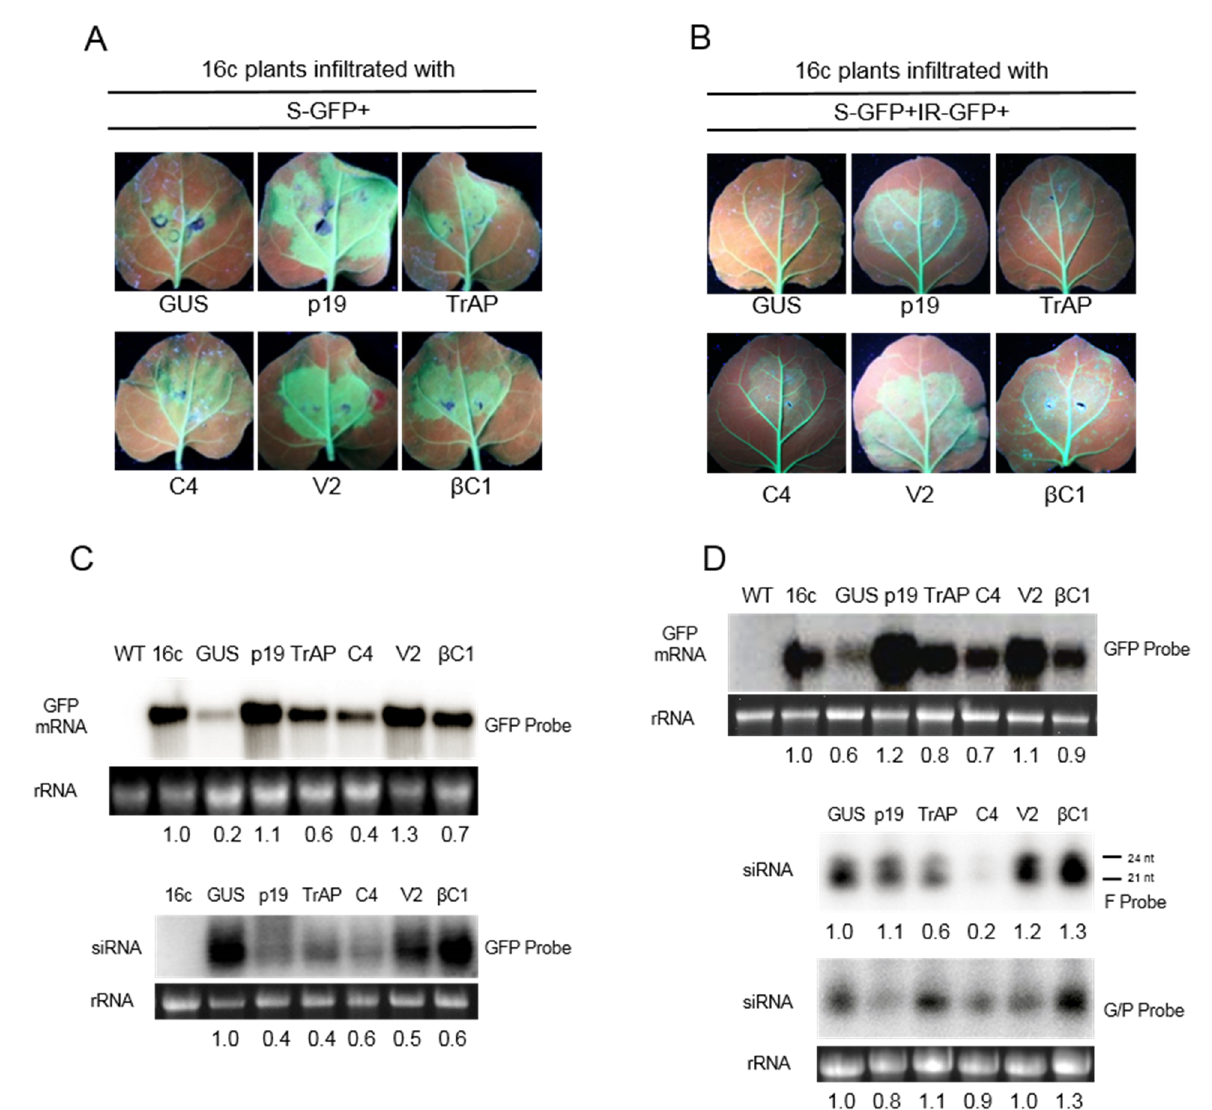
Figure 1. Suppression of gene silencing by proteins encoded by Cotton leaf curl Kokhran virus (CLCuKoV) and Cotton leaf curl Multan betasatellite (CLCuMuB). Leaves of N. benthamiana 16c plants (16c) in which silencing was induced by infiltration with a construct for the expression of the (sense) green fluorescence protein (S-GFP) gene ( A ) or co-agroinfiltrated with S-GFP and a construct for the expression of an inverted-repeat of the GFP gene (IR-GFP) ( B ); In each case the plants were co-infiltrated with constructs for the expression of either β -glucuronidase (GUS), the p19 protein of TBSV (p19), the β C1 protein of CLCuMuB ( β C1), or the transcriptional activator protein (TrAP), C4 protein (C4), or V2 protein (V2) encoded by CLCuKoV, respectively. Plants were photographed under UV illumination at 4 dpi; ( C ) Northern blot of total RNAs extracted from the infiltrated leaf patches of plants